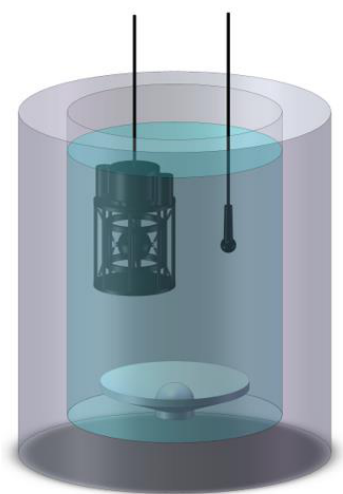
Figure 12 and the acceleration sensitivities can be acquired afterwards. In the experiment, the acceleration sensitivity test is repeated ten times at each frequency point. The acquired acceleration sensitivities of three principal axes are shown in Figure 16, where the upper limits of the error bars are the maximum values and the inferior ones are the minimum values of the ten-time-repeated tests. The theoretical curves of the acceleration responses are also displayed.